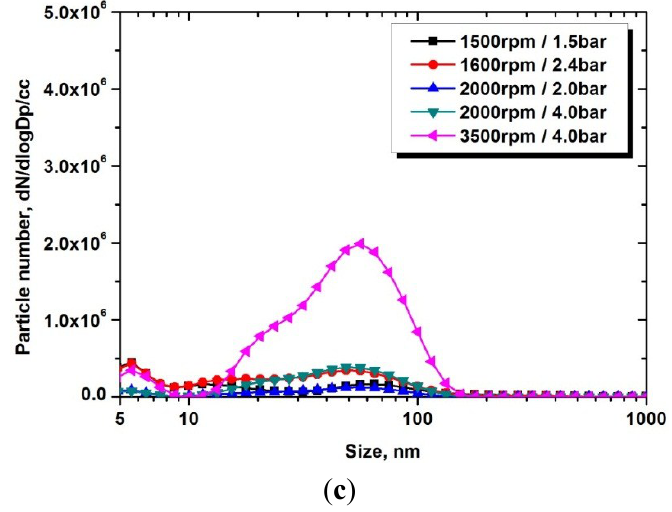
Figure 5. Distributions of the particle size versus the number concentration in various part-load conditions; ( a ) engine out; ( b ) post-TWC; ( c ) post-GPF. The particle size distribution at the engine-out sampling position was bi-modal with 10 nm < d p < 30 nm from 1500 rpm, BMEP 1.5 bars to 2000 rpm, BMEP 2.0 bars, and it consisted of accumulation mode particles with 40 nm < d p < 100 nm formed at 2000 rpm, BMEP 4.0 bars and 3500 rpm, BMEP 4.0